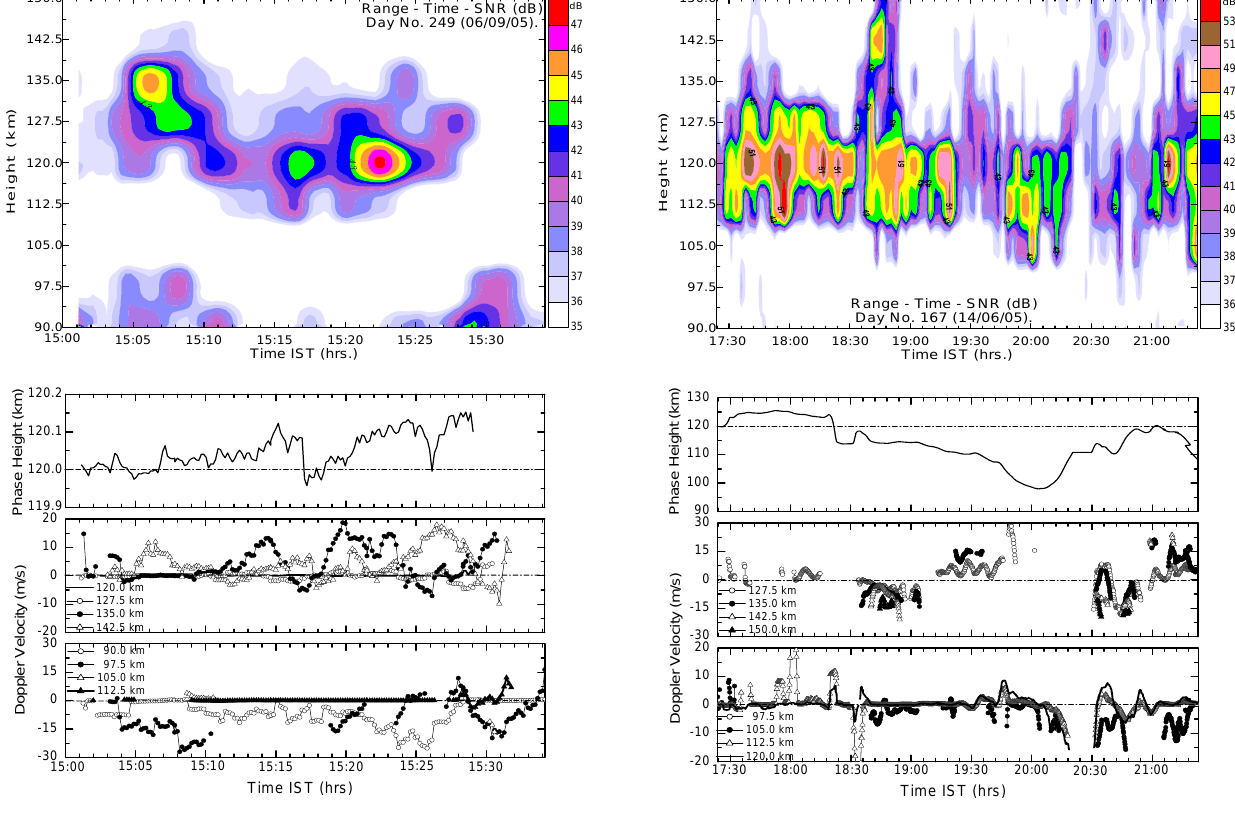
Fig. 5. Same as Fig. 2 except for the Day no. 167, 2005 (14 June